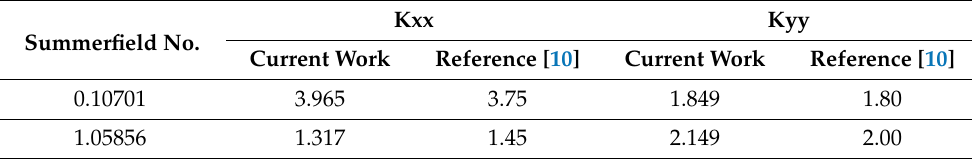
Table 1. Verification of the current